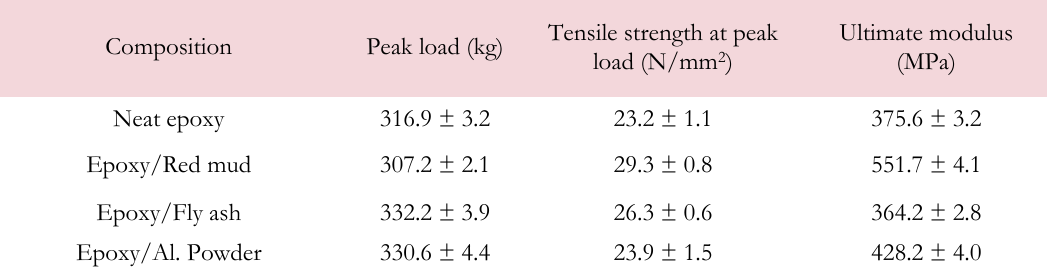
Table 3: Tensile test results of composites at 3 wt% of different filler